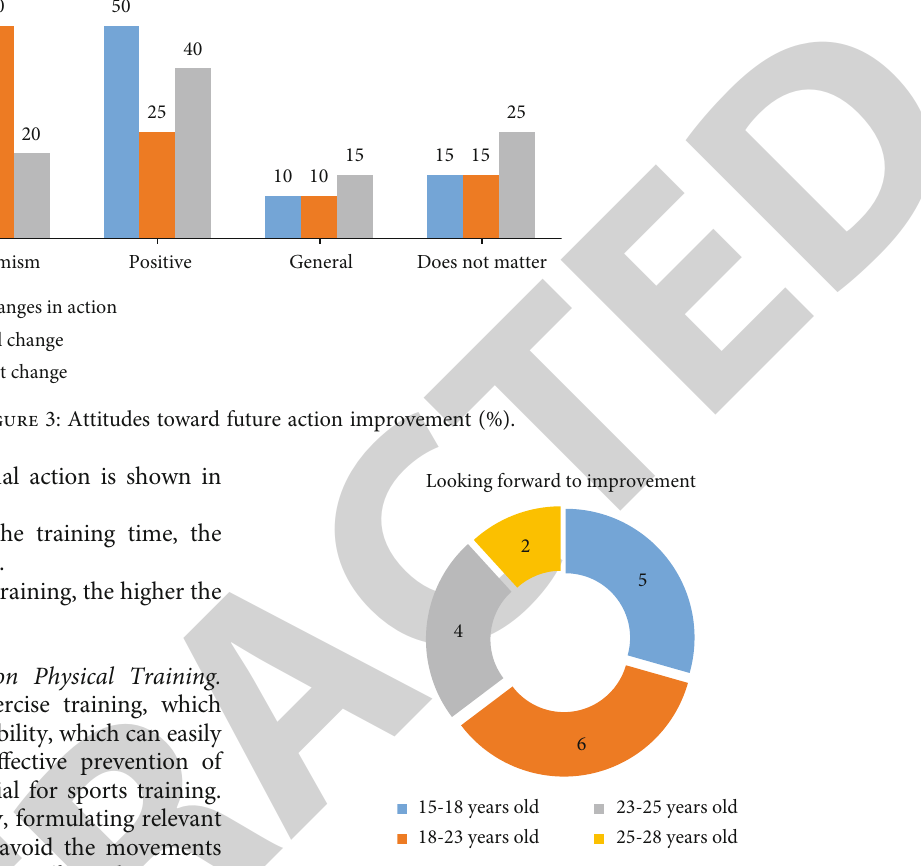
Figure 4: Looking forward to improvement and good